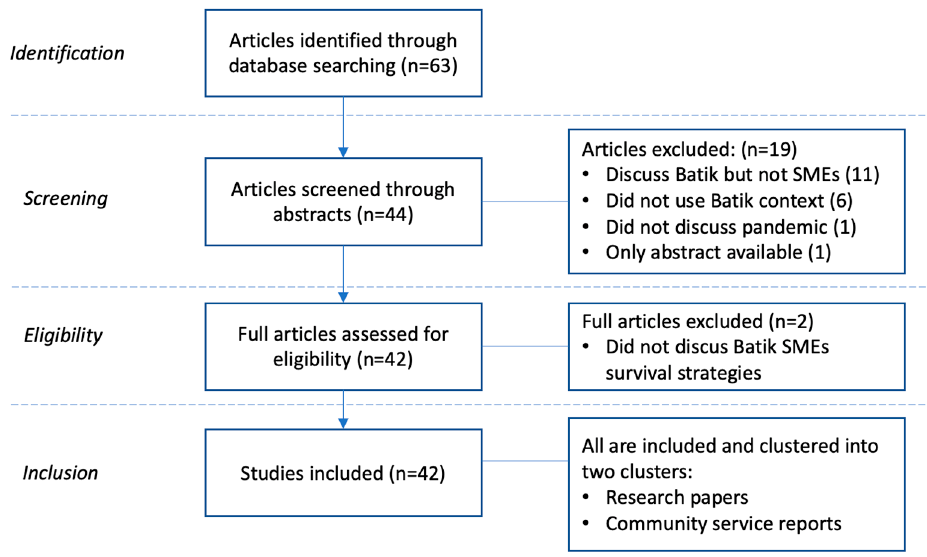
Figure 1. Literature Search and Assessment based on Xiao and Watson (2019).